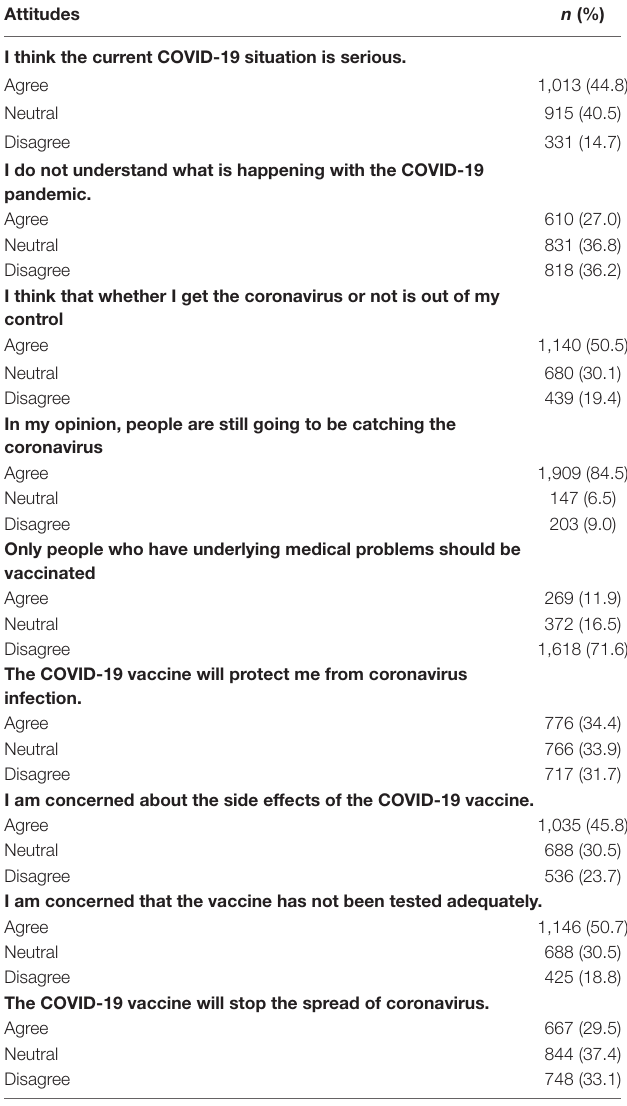
TABLE 2 | Attitude toward the COVID-19 vaccine ( n =